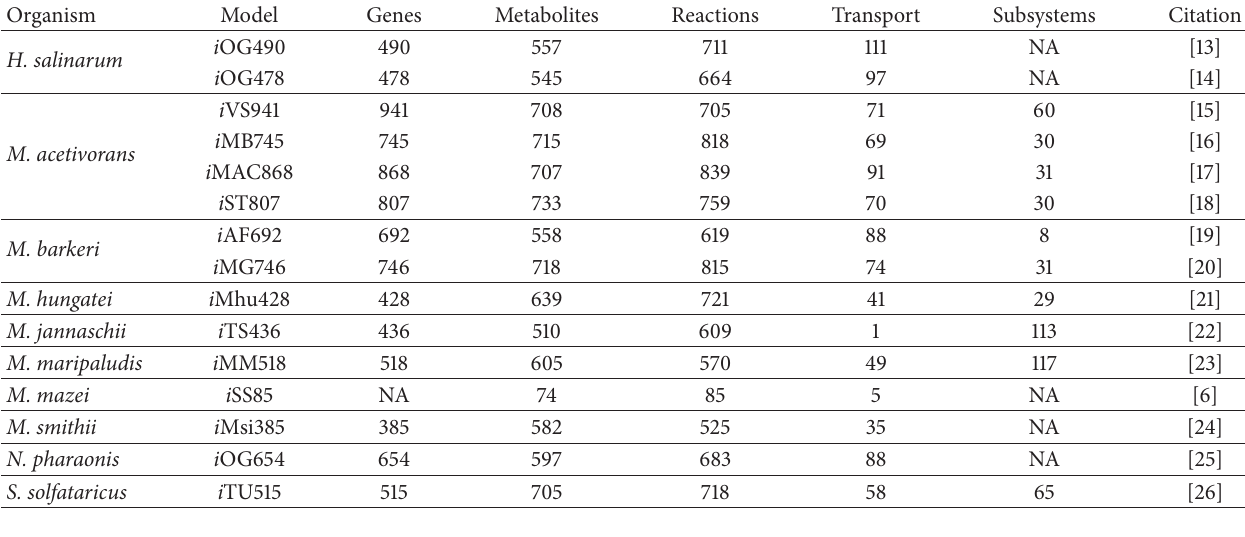
Table 1: Model Statistics . The elementary units of genome-scale metabolic models are genes, metabolites, and reactions. These models consist of (1) a metabolic network that describes the connections between metabolites through reactions (often organized by metabolic subsystem), (2) gene-protein-reaction rules that map the gene dependencies of reactions, and (3) connection to their environment through exchange transport reactions.